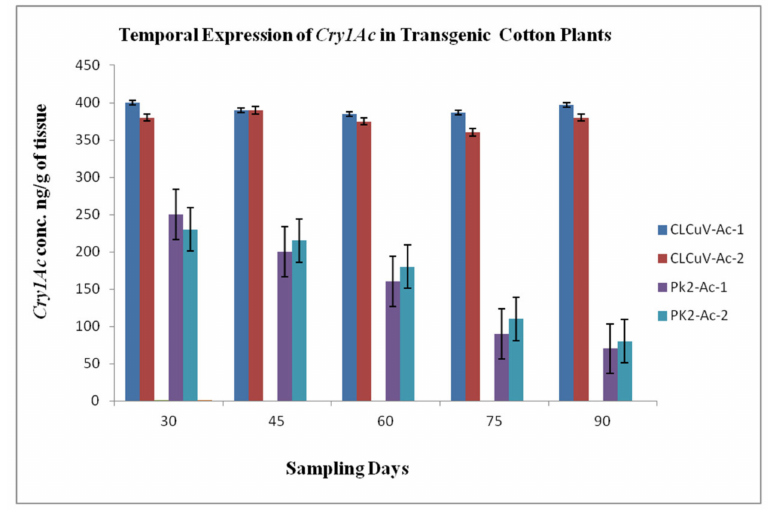
Figure 4. Temporal expression of Cry1Ac gene in transgenic cotton plants. Error bars represent standard deviations.